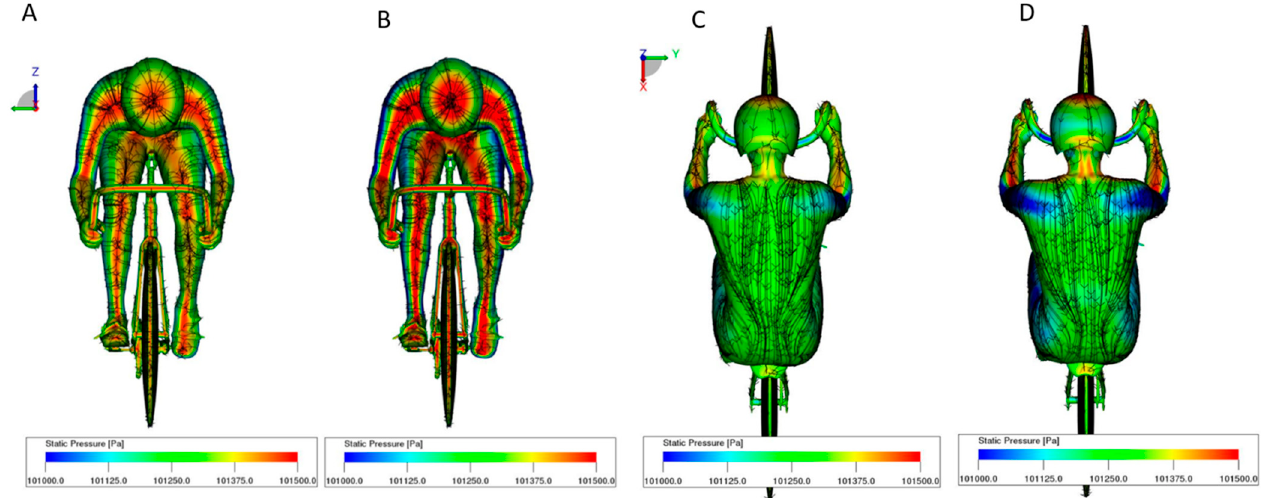
Figure 5. Time-averaged surface pressure distribution (contour and flow lines), ( A , C ) scheme 16 m/s (around 58 km/h) and ( B , D ) of 20 m/s (72 km/h).